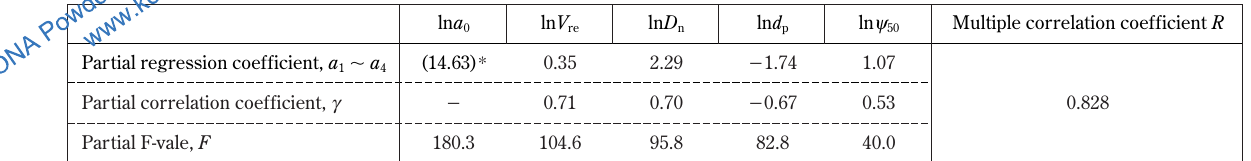
Table 2 Results of multiple regression analysis ( f (cid:4) 25kHz, Case-2)